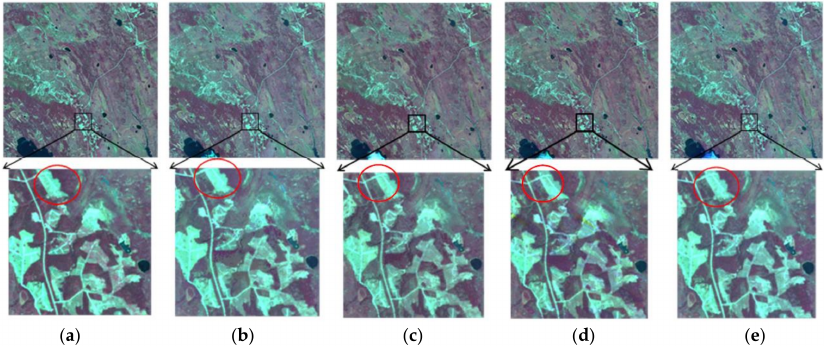
Figure 4. Comparison of forward prediction results of using Landsat image 128 to predict Landsat image 144. ( a ) Actual image; ( b ) Spatial and Temporal Adaptive Reflectance Fusion Model (STARFM); ( c ) Flexible Spatiotemporal Data Fusion (FSDAF); ( d ) SpatioTemporal Image-Fusion Model (STI-FM); ( e ) hybrid color mapping